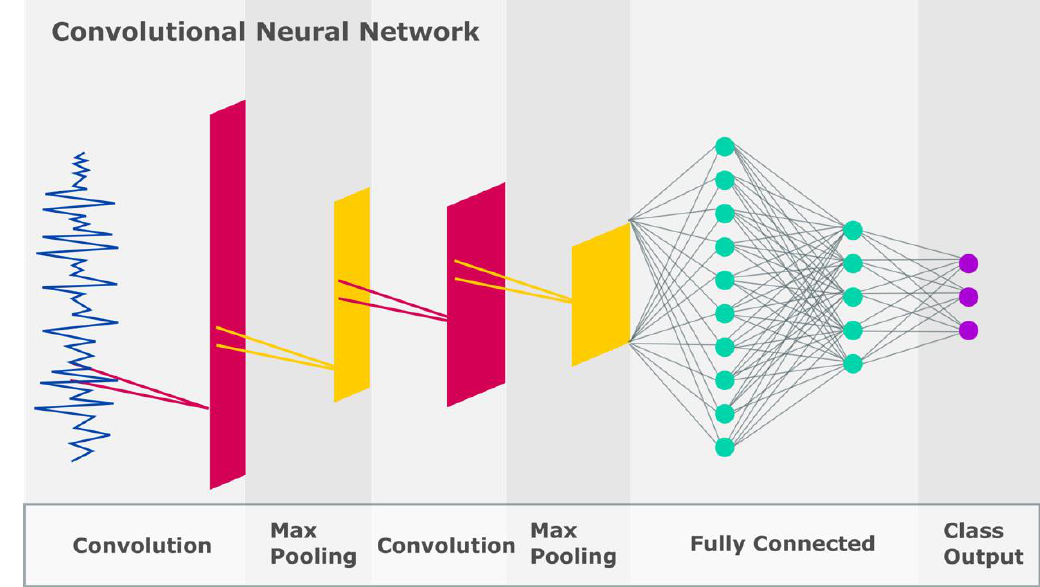
Figure 5. Illustration of the CNN model.